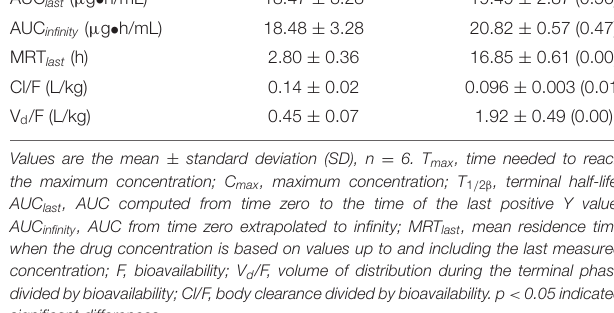
Frontiers in Veterinary Science |